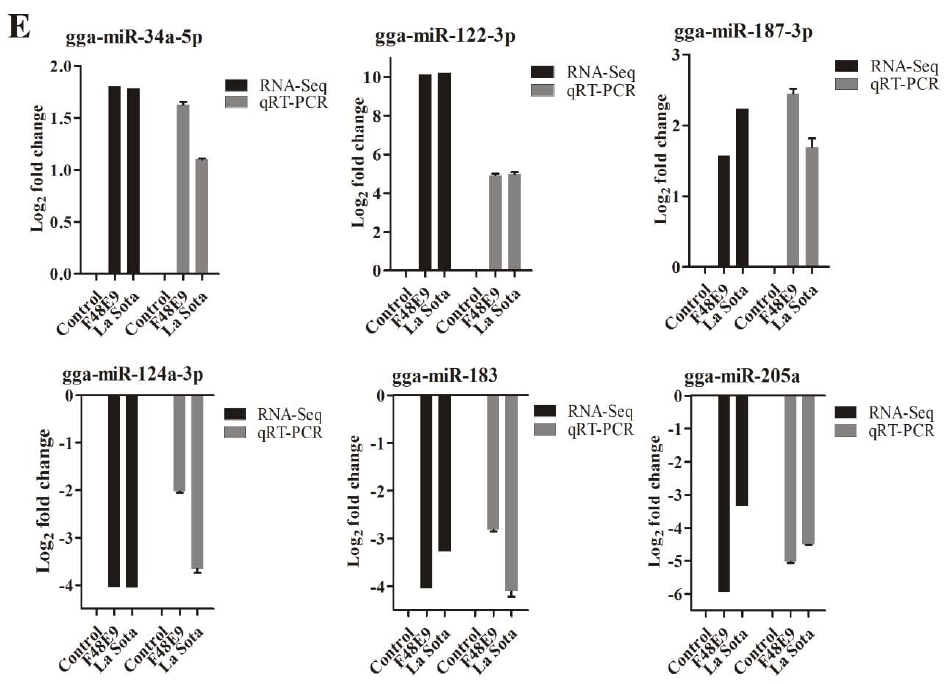
Figure 1. Different expression profiles of microRNAs in chicken embryos infected with F48E9 or La Sota. ( A ) Size distribution of sequenced small RNA-seq reads. ( B ) Pie charts of small RNA-seq showing the percentage of small RNA components in F48E9 or La Sota infected tissue and control tissue. ( C ) Heatmap of 98 differentially expressed miRNAs shared by F48E9, La Sota, and the control. ( D ) Scatter plots showing the upregulated and downregulated differentially expressed miRNAs between F48E9 and control, La Sota and control, and La Sota and F48E9. Red, green and blue dots are representative the number of upregulated, downregulated and unchanged genes, respectively. ( E ) Validation of RT ‐ qPCR analysis of gga ‐ miR ‐ 34a ‐ 5p, gga ‐ miR ‐ 122 ‐ 3p, gga ‐ miR ‐ 187 ‐ 3p, gga ‐ miR ‐ 124a ‐ 3p, gga ‐ miR ‐ 183, and gga ‐ miR ‐ 205a in different infected and non ‐ infected tissues.